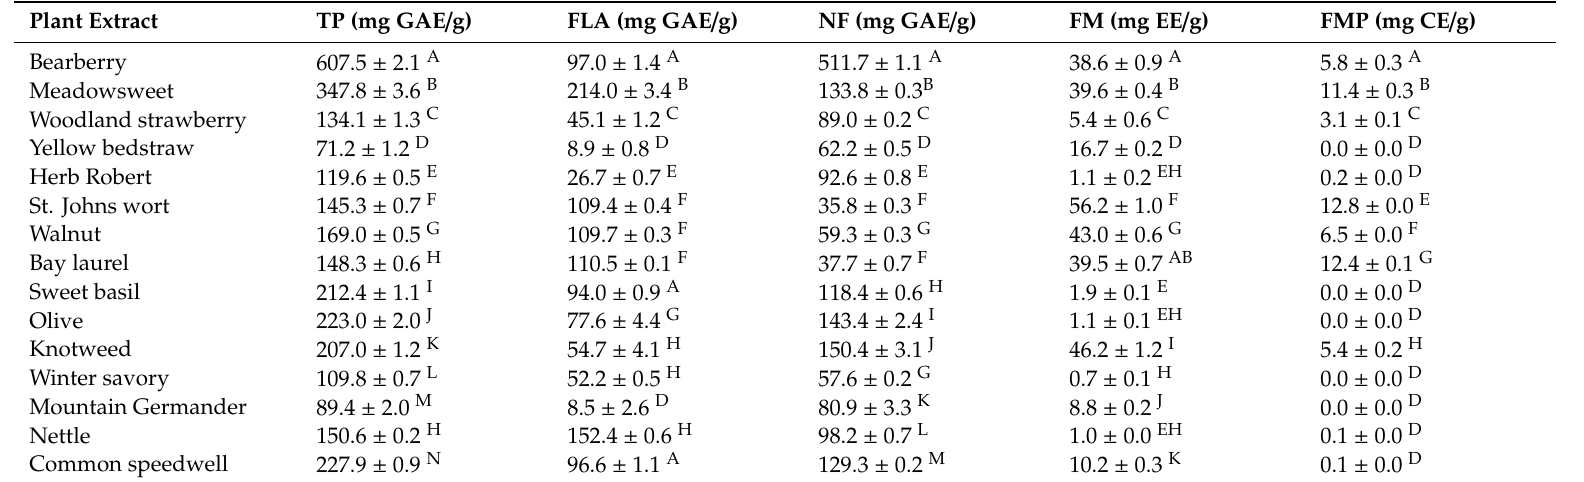
Table 2. Total phenolics (TP), flavonoids (FLA), non-flavonoids (NF), flavanol monomers (FM), and flavanol monomers and procijanidins (FMP) in investigated